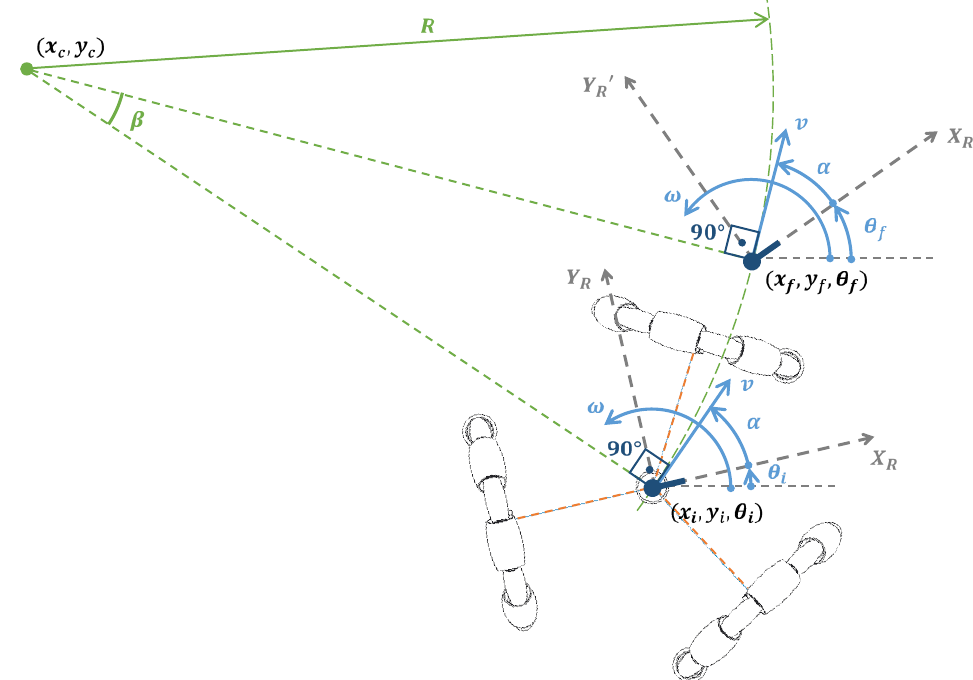
Figure 3. Representation of the displacement of an omnidirectional mobile robot located at (𝑥 𝑖 ,𝑦 𝑖 , 𝜃 𝑖 ) when executing a motion command 𝑀 = (𝑣, 𝛼, 𝜔, 𝑡 𝑟 ) . 𝑅 is the radius of the circular trajectory, (𝑥 𝑐 ,𝑦 𝑐 ) is the location of the center of the circular trajectory, 𝛽 is the angular displacement of the robot along the circular path, and (𝑥 𝑓 , 𝑦 𝑓 ,𝜃 𝑓 ) is the final position of the robot. The final position of the mobile robot in the world frame after